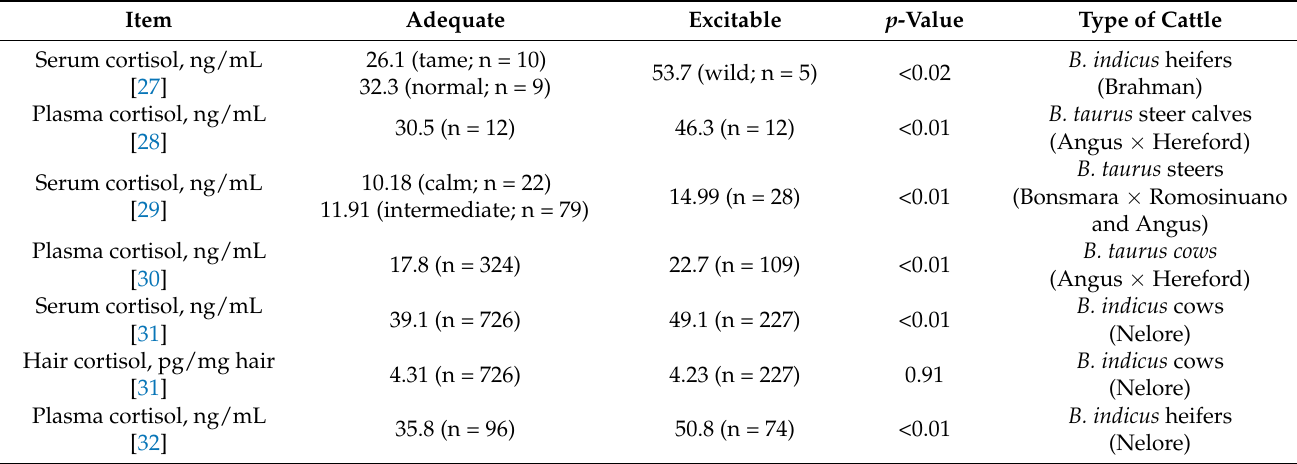
Table 1. Concentrations of plasma, serum, and hair cortisol in beef cattle classified according to their temperament type. In all identified studies that followed the selection criteria 1 (n = 6) 2 , cattle with more excitable temperaments 3 have significantly higher plasma or serum concentrations of cortisol. No differences between treatment types were identified for concentrations of cortisol in hair, a marker of chronic stress in beef cattle [23]. This may suggest that excitable cattle have similar basal concentrations of cortisol compared to cattle adequate